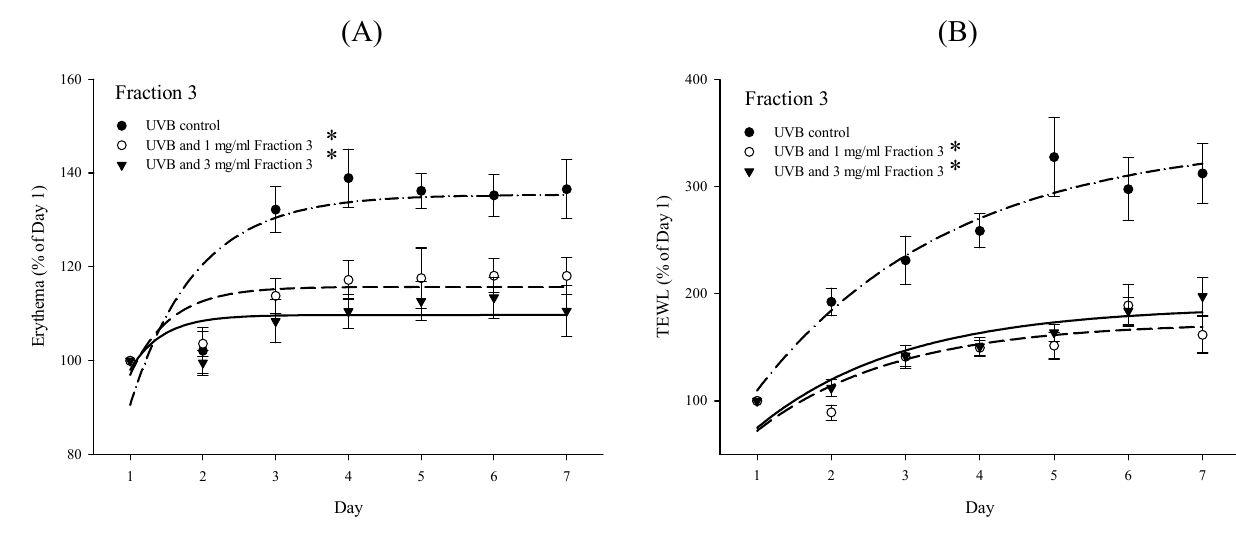
Figure 3. Change in physiology parameters on the skin surface after treatment with Fraction 3. ( A ) Change in erythema after treatment with Fraction 3. ( B ) Change in transepidermal water loss (TEWL) after treatment with Fraction 3.